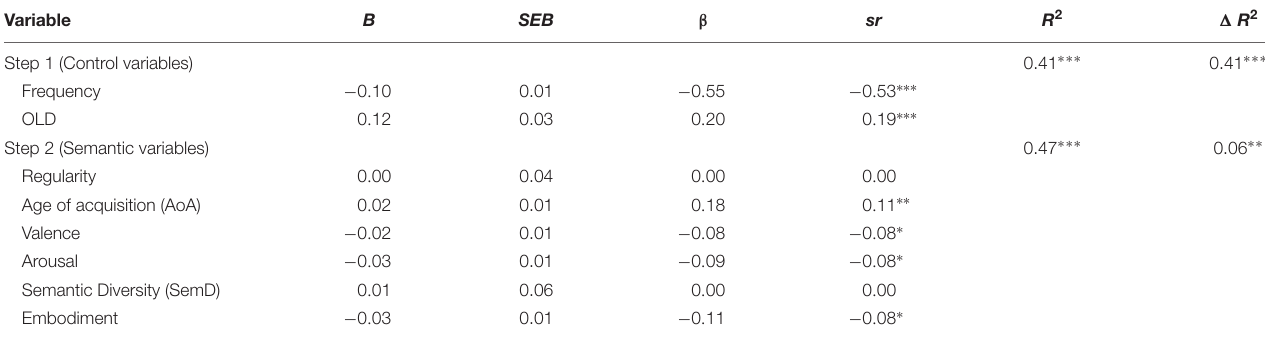
TABLE 3 | Regression coefficients from item-level regression analyses for standardized LDT latencies, Experiment